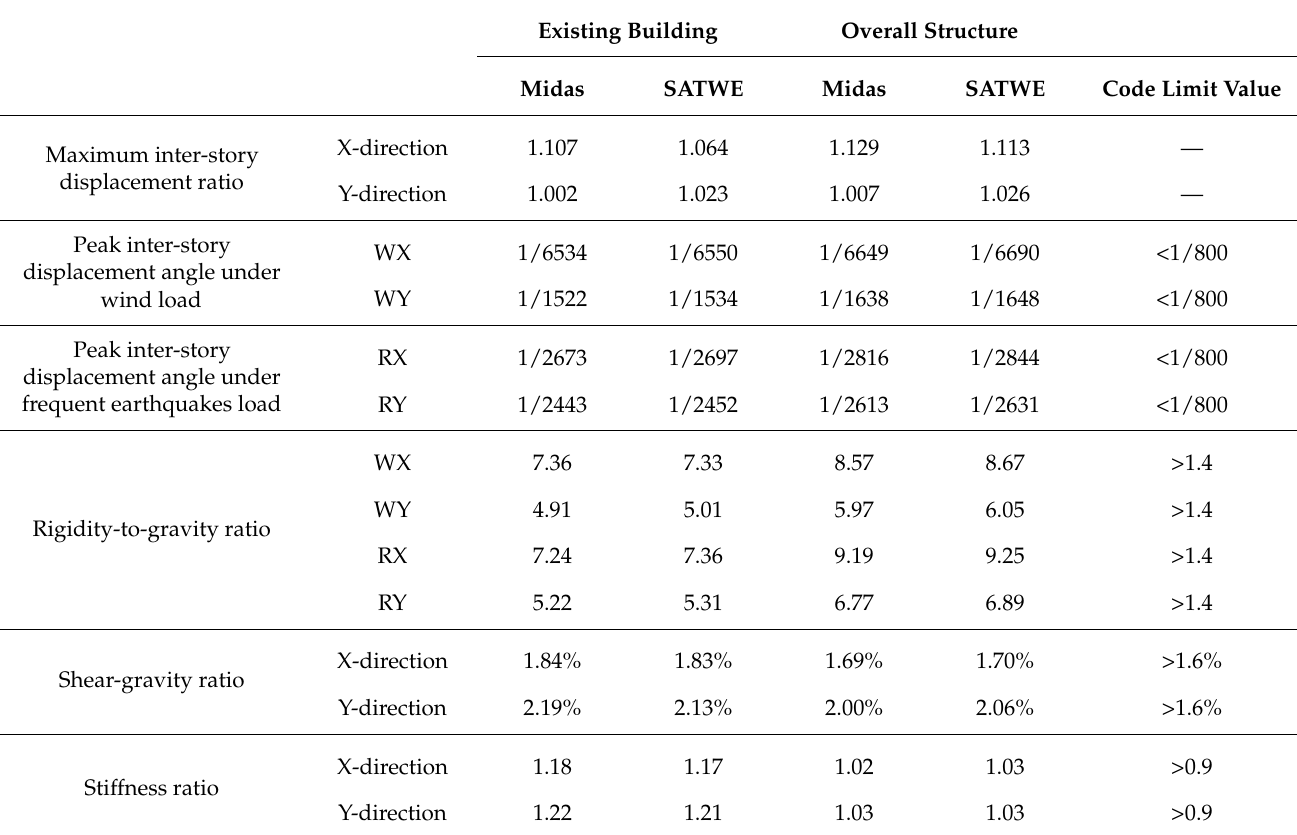
Table 4. Result of reaction spectrum